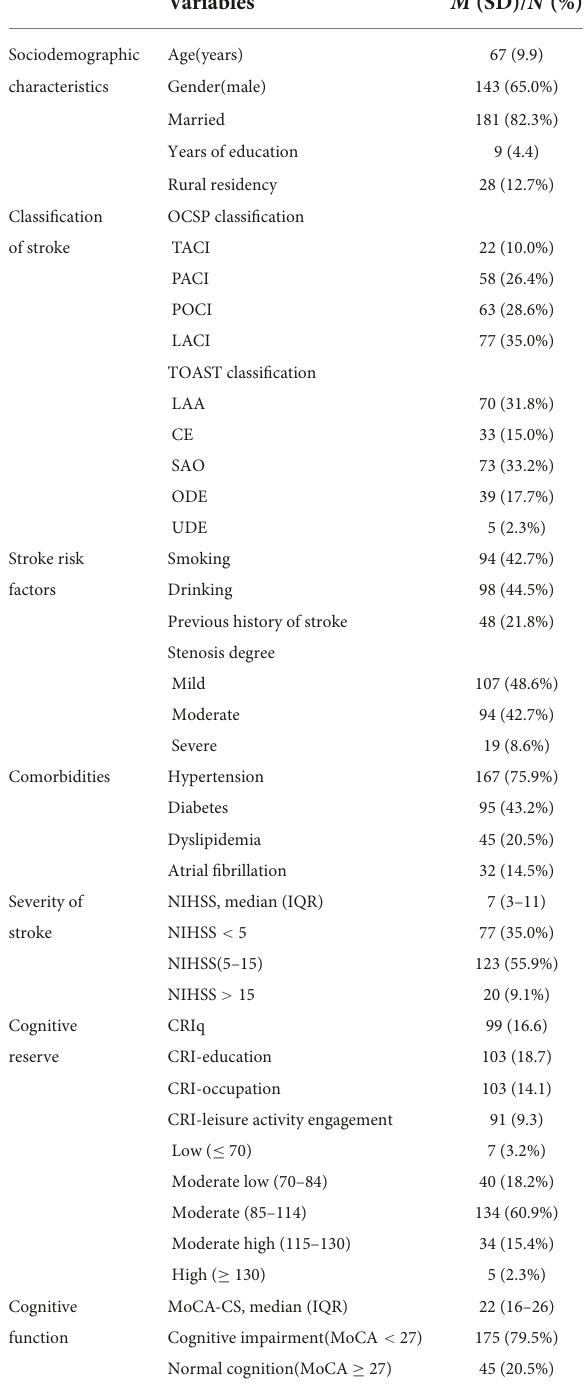
TABLE 1 Characteristics of patients with Acute Ischemic Stroke ( N =